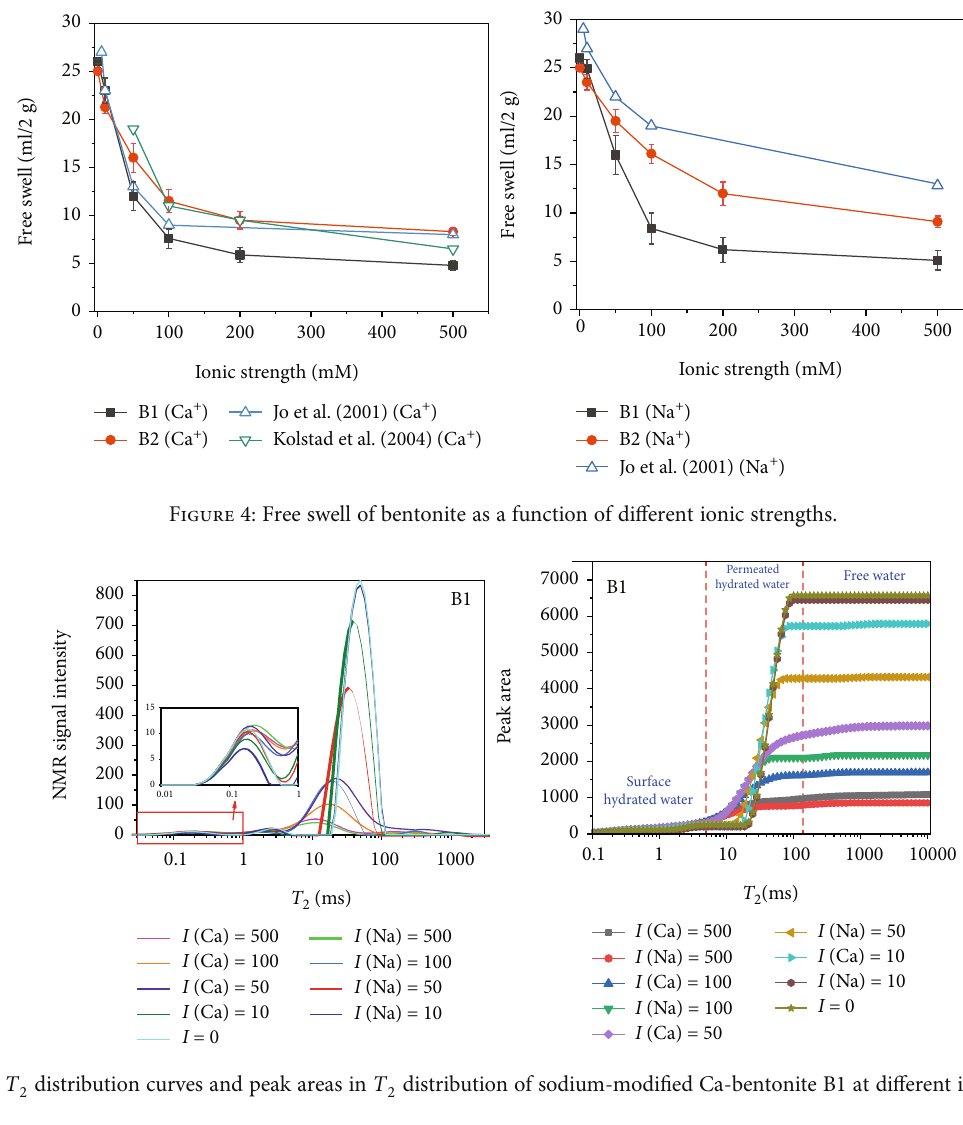
Figure 5: T 2 distribution curves and peak areas in